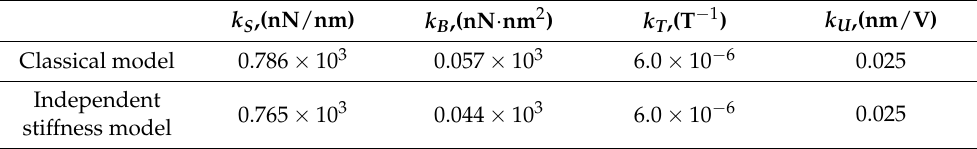
Table 1. Physical parameters for chiral ( 5,5 ) SWCNT (here, α , β and E come from Ref. [3]). k S ,(nN / nm) k B ,(nN · nm 2 ) k T ,(T − 1 ) k U ,(nm / V) Classical model 0.786 × 10 3 0.057 × 10 3 6.0 × 10 − 6 0.025 Independent 0.765 × 10 3 0.044 × 10 3 6.0 × 10 − 6 stiffness model